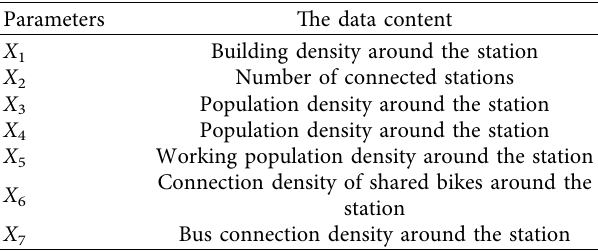
Table 3: Model input data content.